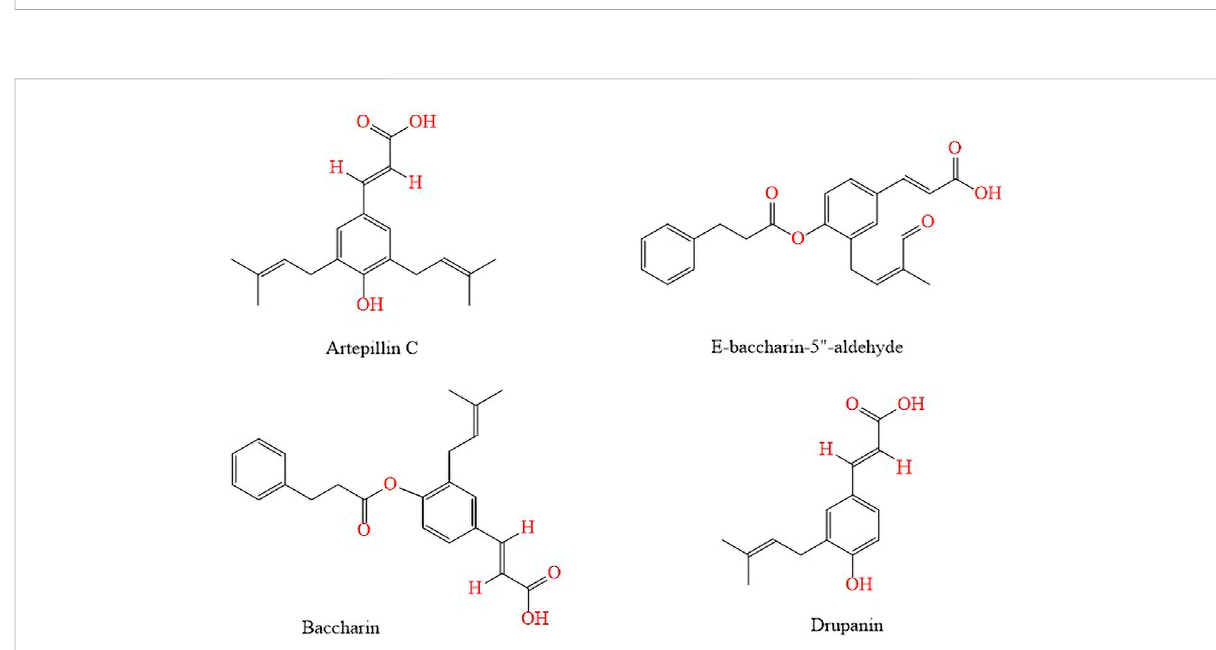
FIGURE 5 Prenylated derivatives and cinnamic derivatives found in B. dracunculifolia hydroalcoholic extracts.